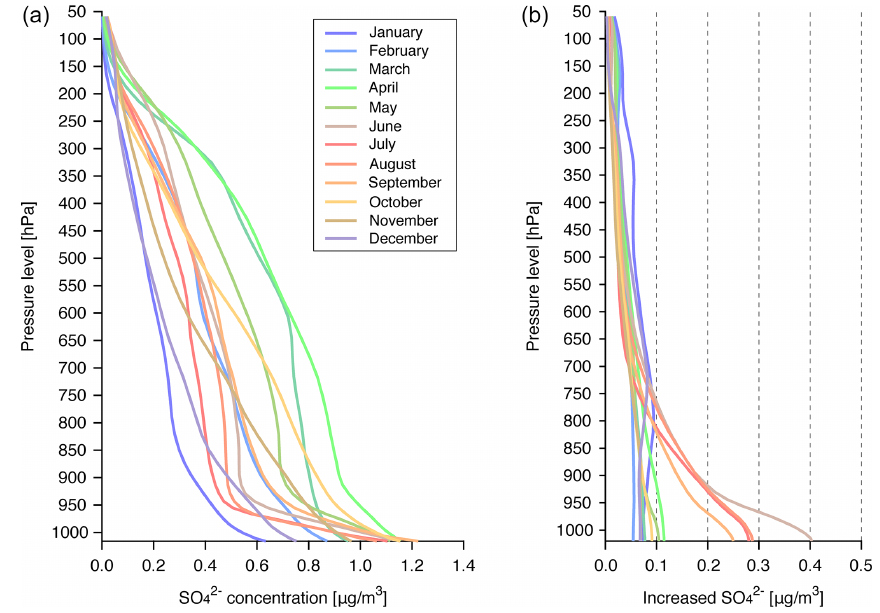
Figure 7. Vertical profile of simulated SO 2 − concentration of each month in 2010 at the edge of western USA (see Fig. 4): (a) original 4 H-CMAQ and (b) increased concentration by the incorporation of volcanic SO 2